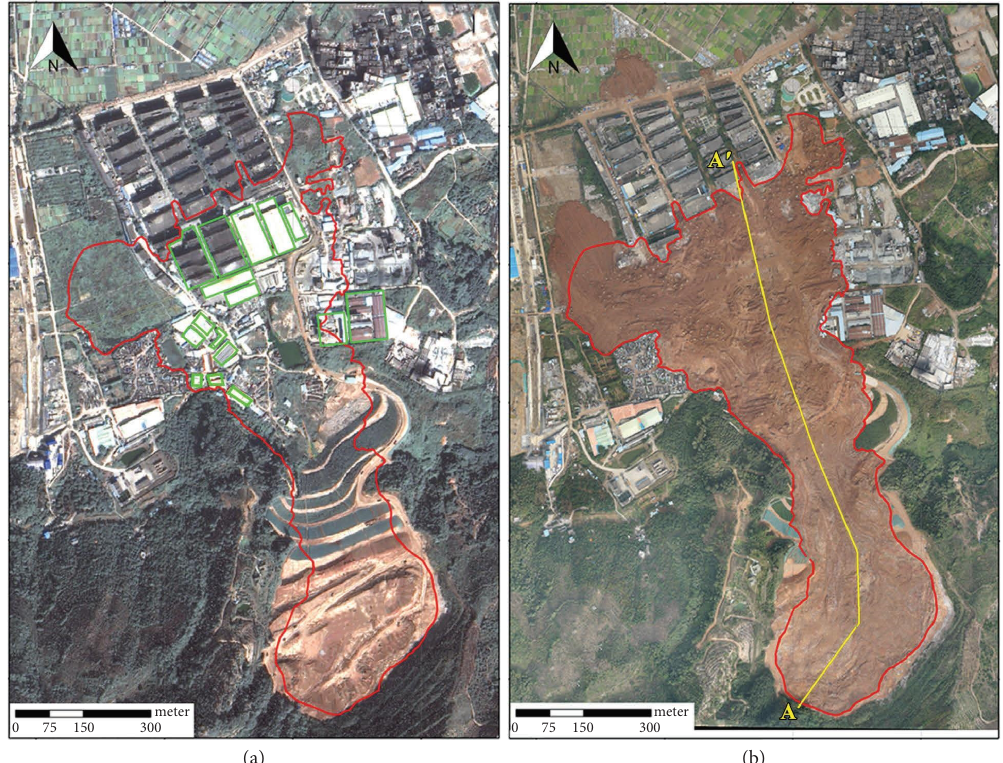
Figure 3: Shenzhen 2015 landslide: (a) satellite image before the landslide (18 December 2015); (b) aerial photo after the landslide (23 December 2015). Te red solid line indicates the actual deposition boundary, the green solid line indicates the main damaged buildings, and the yellow solid line represents the profle line along which the dynamic characters will be extracted in the numerical modeling.